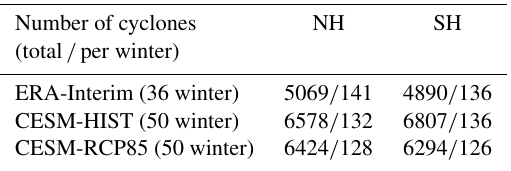
Table 1. Number of wintertime extratropical cyclones in ERA- Interim, CESM-HIST, and